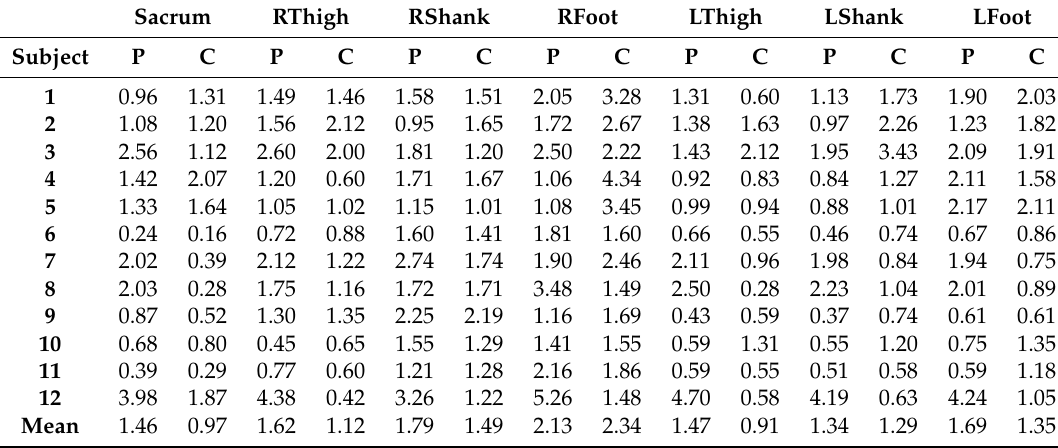
Table 3. Pitch root mean square error (RMSE) (degrees) by subject and IMU for the proposed (P) method and the control (C) method. Sacrum RThigh RShank RFoot LThigh LShank